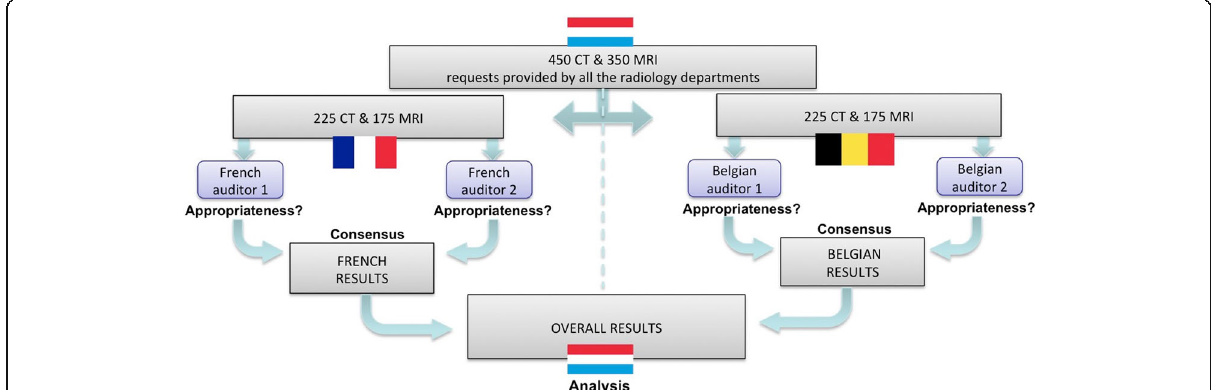
Fig. 1 Flowchart showing the methodology of the